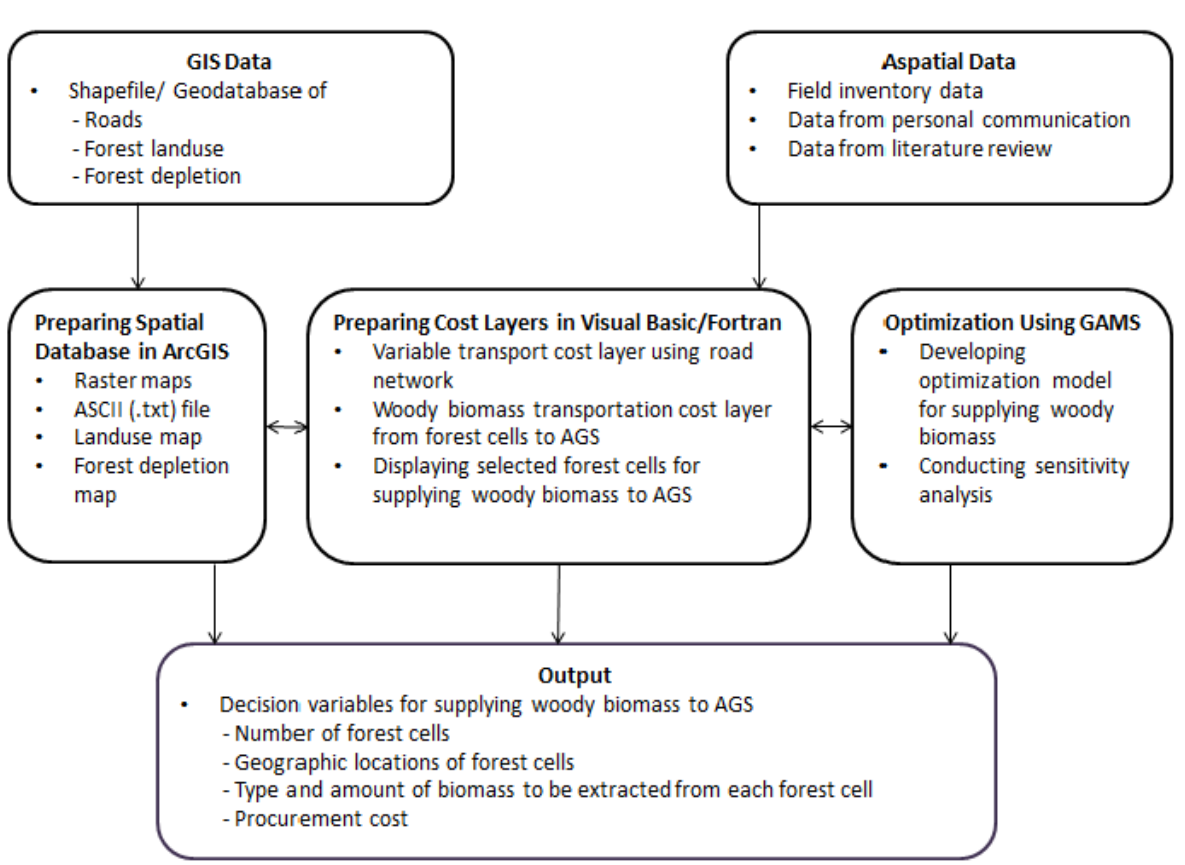
Figure 2. Flow chart for supplying woody biomass to the AGS at minimum cost using the GIS-based integrated NLDP